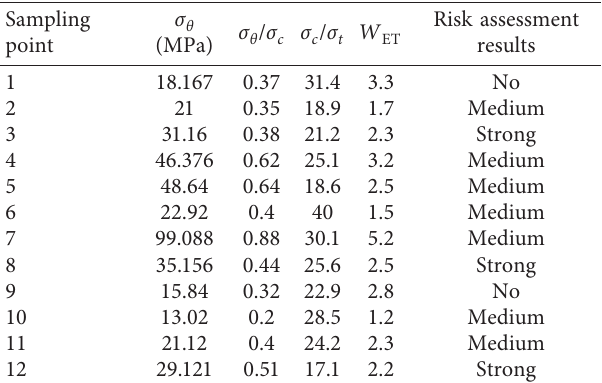
(a) Figure 5: Schematic test of mechanical parameters and field sampling points of kimberlite. Table 3: Sample attributes and corresponding rock burst risk assessment